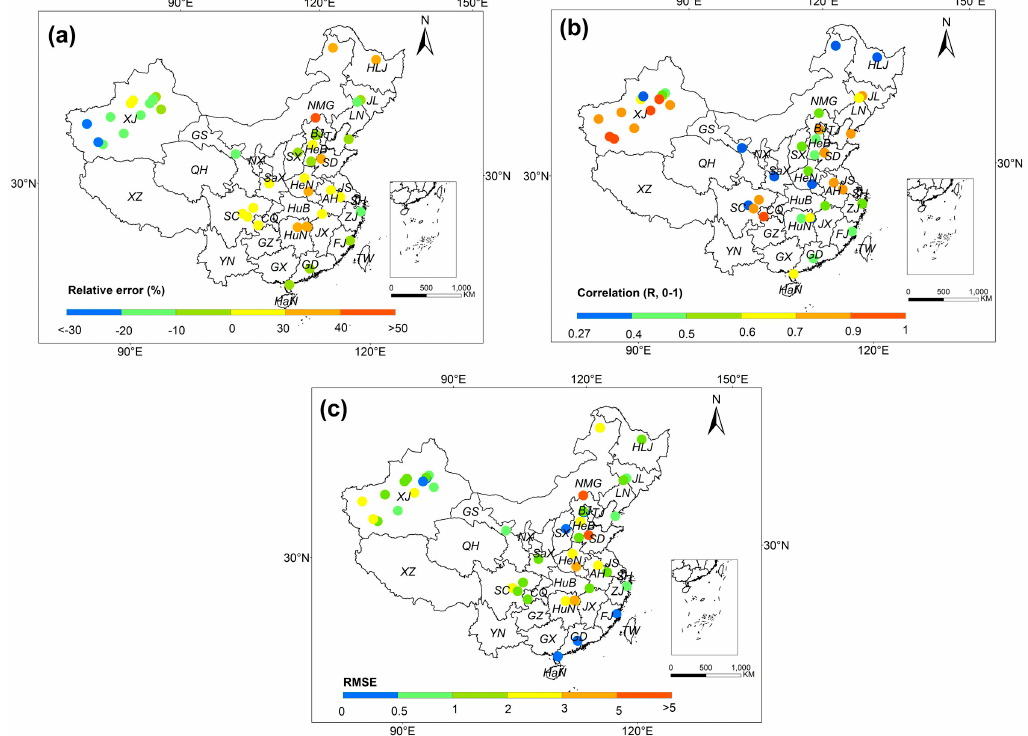
Figure 3 . Spatial distribution of the relative error ( a ), correlation ( b ) and root-mean-square error (RMSE) ( c ) of the estimated ground NH 3 concentration (µg N m − 3 ) at 44 NNDMN sites.